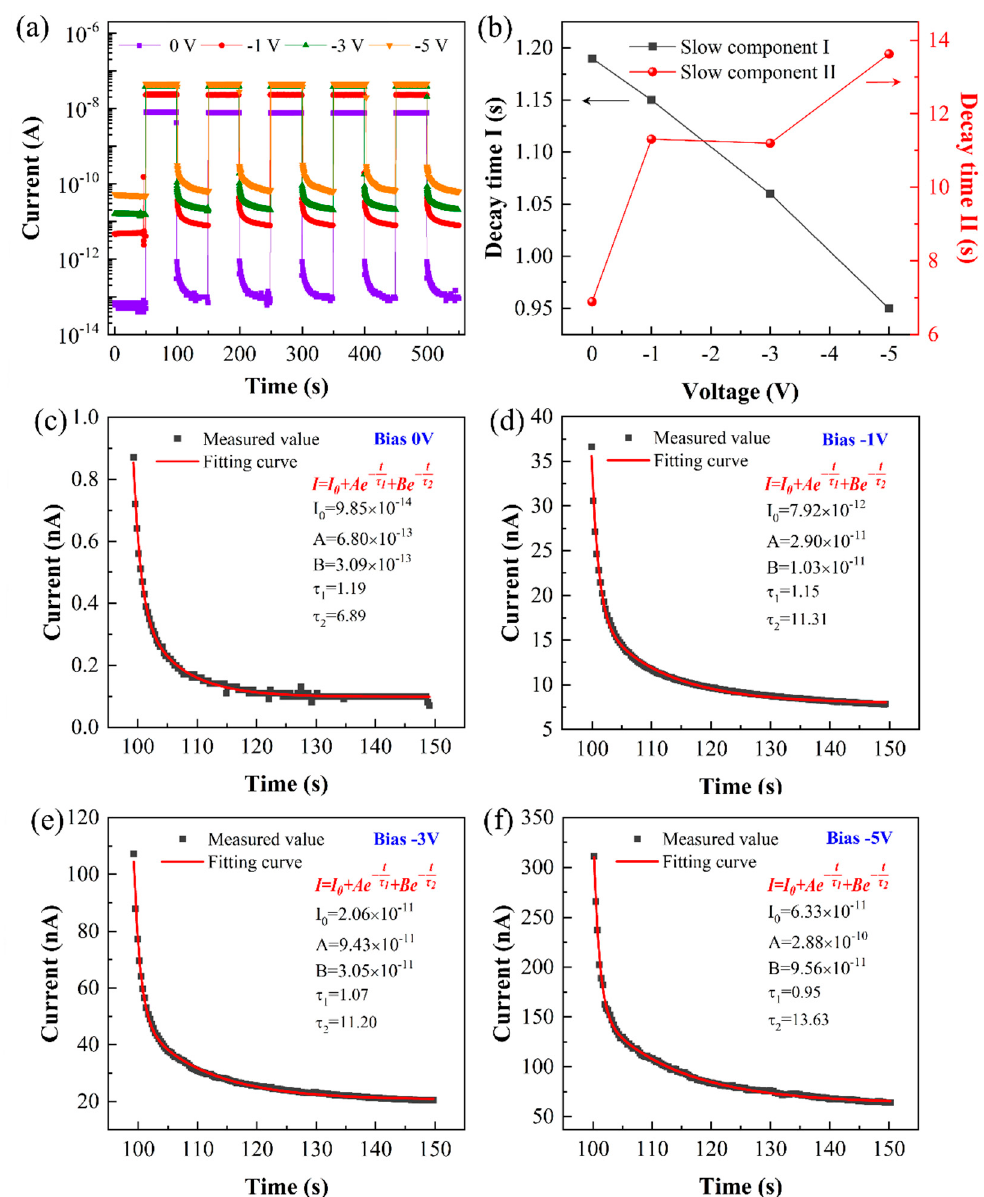
Figure 3. ( a ) Time response of device-A upon the 350 nm light illumination measured by a mechanical chopping method. ( b ) The relaxation time τ 1 / τ 2 under di ff erent bias voltages. ( c – f ) The slow component during the decay process and its corresponding fitting curve by bi-exponential relaxation equation.